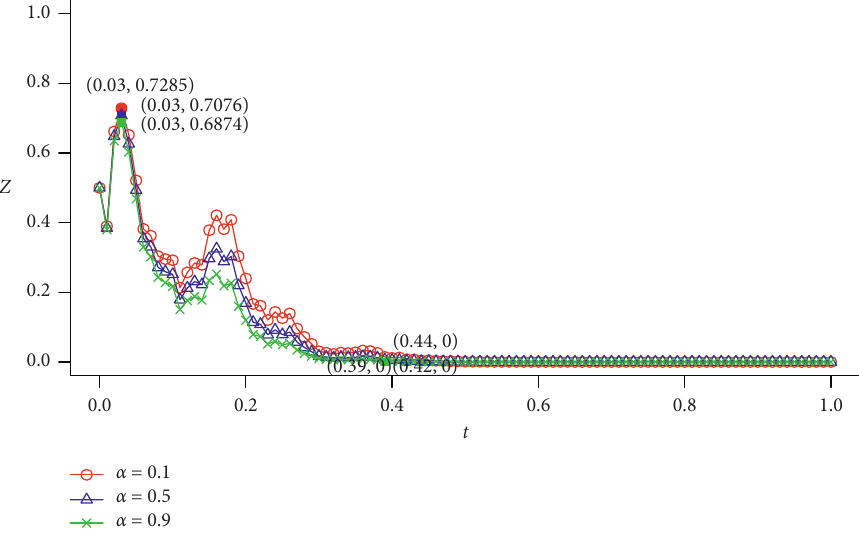
Figure 2: The impact of tax reduction ratio α on loan enterprise’s strategy